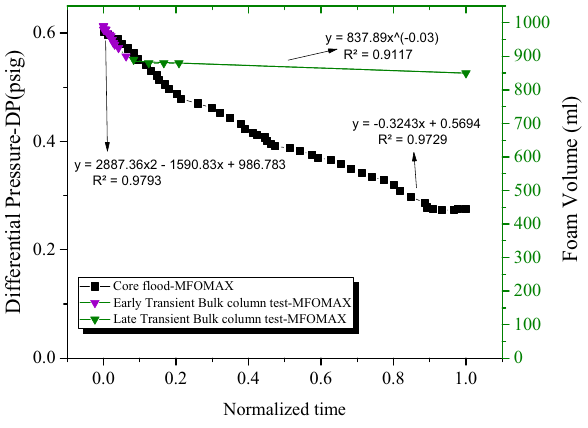
Fig. 10 Side-by-side performance comparison of bulk and coreflood foam stability tests of ENORDET